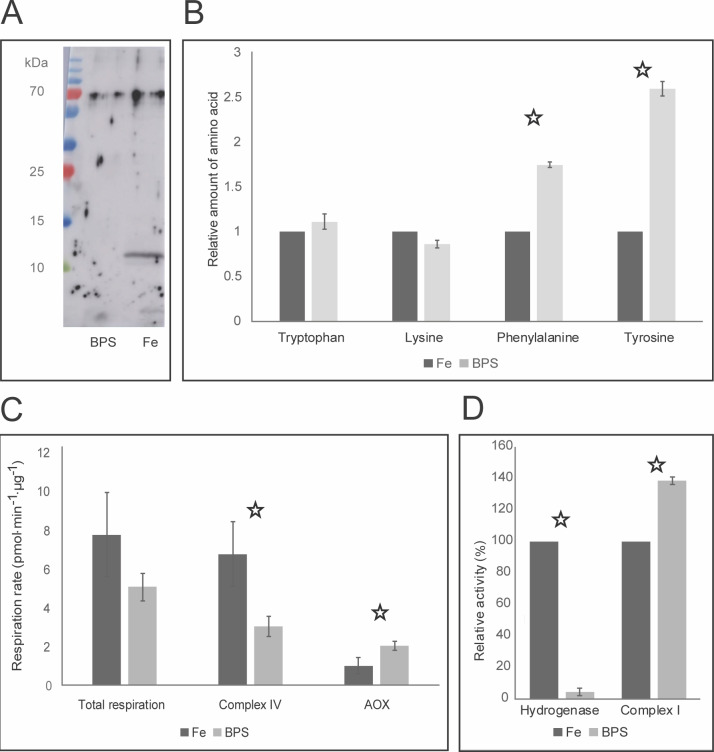
Effect of iron deficiency on N. fowleri.(A) Downregulation of N. fowleri hemerythrin under iron-deficient conditions. Results from the Western blot analysis of cells cultivated under iron-rich (Fe) and iron-deficient (BPS) conditions using an antibody against Naegleria gruberi hemerythrin. Equal protein concentrations were loaded, and the loading control is shown in S1(D) Fig. The gel represents one of three independent replicates. (B) Cellular content of selected amino acids in N. fowleri cells cultivated under iron-rich and iron-deficient conditions. Relative amounts of phenylalanine and tyrosine were significantly increased under the iron-deficient condition, while those of tryptophan and lysine remained unchanged. t-test p-values <0.01 are marked with a star. The total protein concentration was equal in all the samples, and the values shown are relative to those under the iron-rich conditions for each amino acid. Fe, cells cultivated under iron-rich conditions; BPS, cells cultivated under iron-deficient conditions. Data are presented as the means ± SD from three independent replicates. (C) Respiration of N. fowleri grown under iron-rich and iron-deficient conditions. Using selective inhibitors of complex IV (potassium cyanide) and of alternative oxidase (salicyl-hydroxamic acid), the contribution of alternative oxidase and complex IV activity was assessed with respect to total respiration levels. AOX, alternative oxidase; Fe, cells cultivated under iron-rich conditions; and BPS, cells cultivated under iron-deficient conditions. The t-test p-values <0.01 are marked with a star. Data are presented as the means ± SD from five independent replicates. (D) Activity of hydrogenase and NADH:ubiquinone dehydrogenase (complex I) under iron-rich and iron-deficient conditions. While hydrogenase was significantly downregulated, complex I was significantly upregulated as a result of the iron-deficient conditions. Relative values are shown. Fe, cells cultivated under iron-rich conditions; and BPS, cells cultivated under iron-deficient conditions. The t-test p-values <0.01 are marked with a star. Data are presented as the means ± SD from four independent replicates.